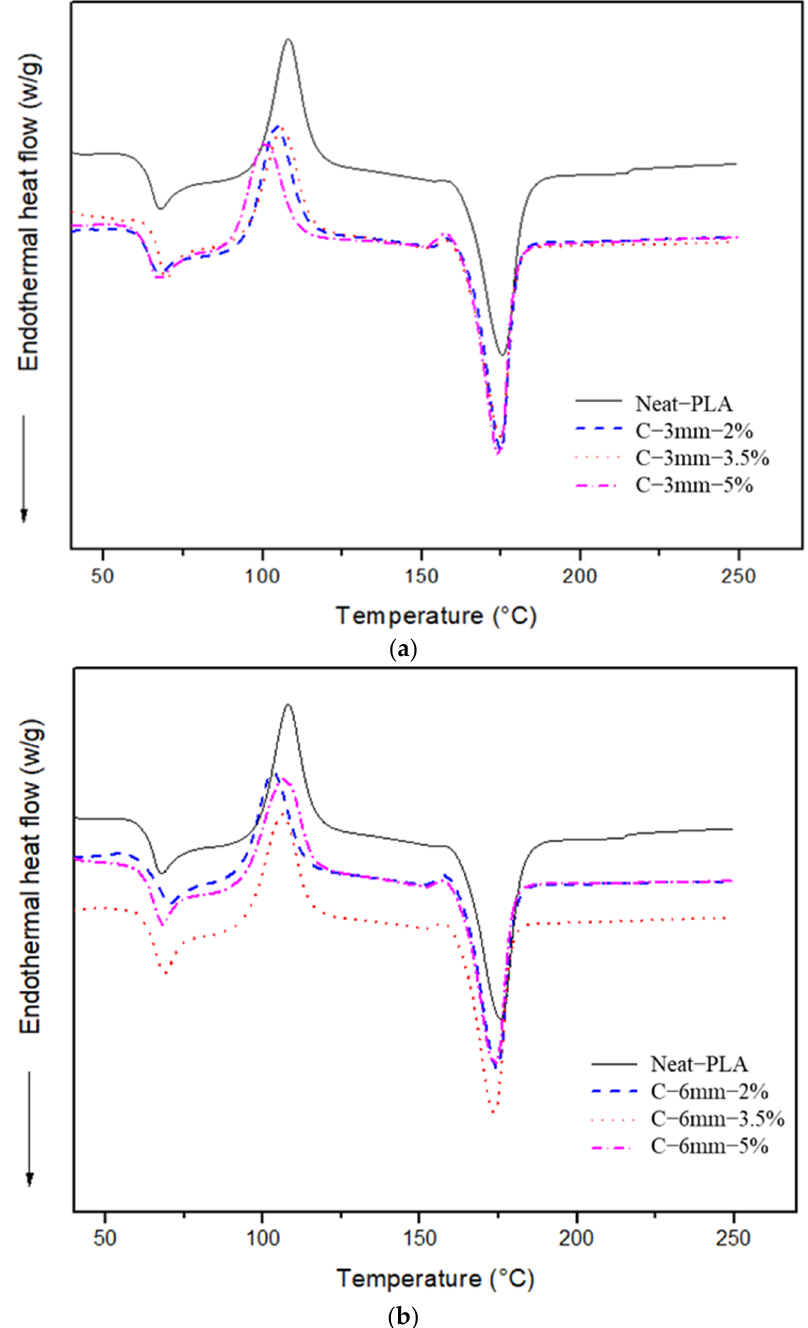
Figure 14. DSC analysis data: ( a ) 3 mm fiber length group; ( b ) 6 mm group and Neat-PLA. The 6 mm fiber length specimens presented a decrease in T c compared to Neat-PLA, exhibiting the same behavior as the 3 mm length fiber-reinforced composites. For the two cases of C-3 mm-(3.5 and 5 wt.%) and 6 mm-(2, 3.5, and 5 wt.%) fiber length specimens, a small decrease in Tm was observed when compared to Neat-PLA. Akonda et al. [48], showed that the flax/PLA composite presented a decrease in Tm at the beginning of the melting temperature of the composites. However, the C-3 mm-2% specimens showed no significant change in Tm. These results are in accordance with results found in the literature